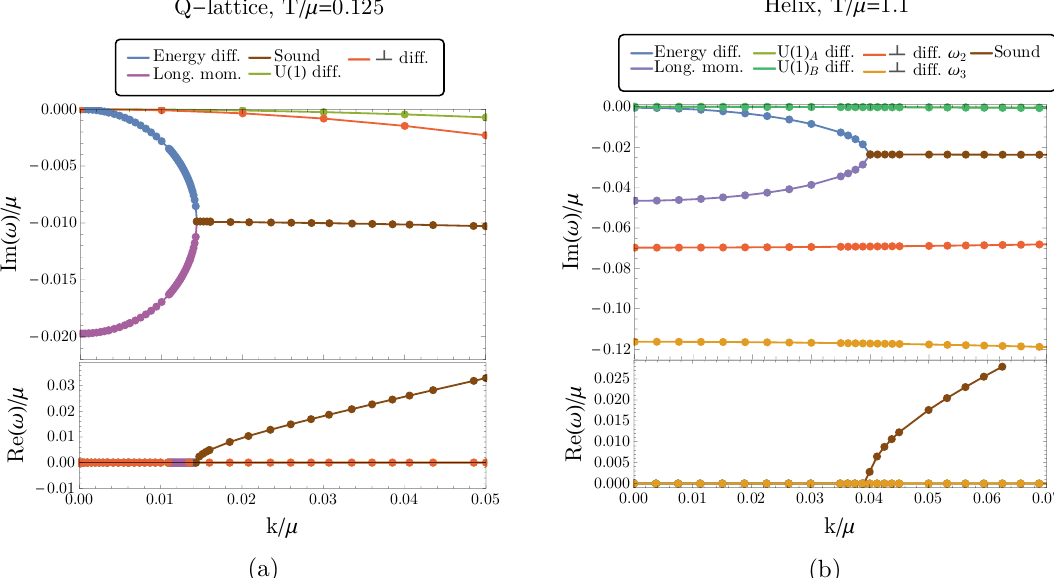
Figure 2. Quasinormal modes at high temperature. The e(cid:11)ective momentum relaxation scale is weak and therefore the modes follow the behaviour dictated by hydrodynamics with weakly broken translations, see section 2. The imaginary (top) and the real (bottom) parts of the QNMs are shown for both models. At zero wavelength k , there modes are purely imaginary. As k increases, the longitudinal momentum dissipation mode collides with the energy di(cid:11)usion mode resulting in the \damped sound". Moreover, the other purely imaginary modes are: 2 extra di(cid:11)usion modes in the Q-lattice and 2 di(cid:11)usion plus 2 dissipation modes in the helix; their origin is discussed in section 5.1. Note that the U(1) A and U(1) B di(cid:11)usion modes on the right panel lie on top of each other and therefore are almost